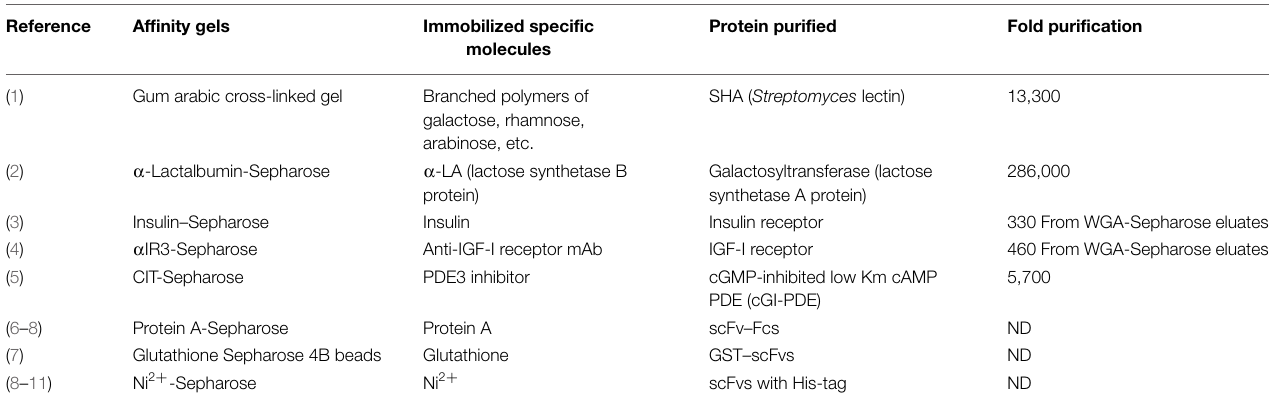
TABLE 1 | Examples of different affinity chromatographies